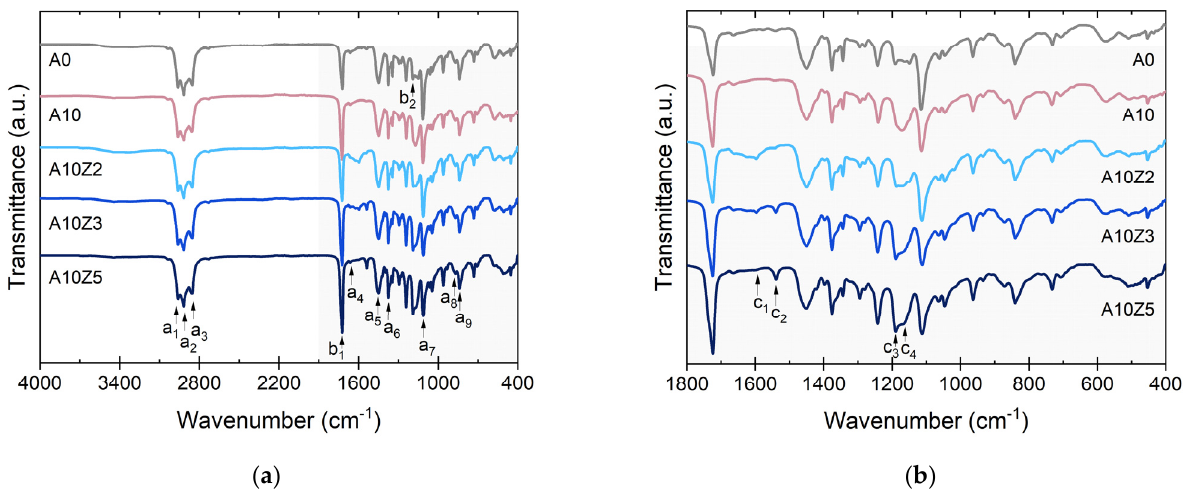
Figure 6. Infrared spectra of TPEs reinforced with A and ZnO: ( a ) general and ( b ) fingerprint zone.